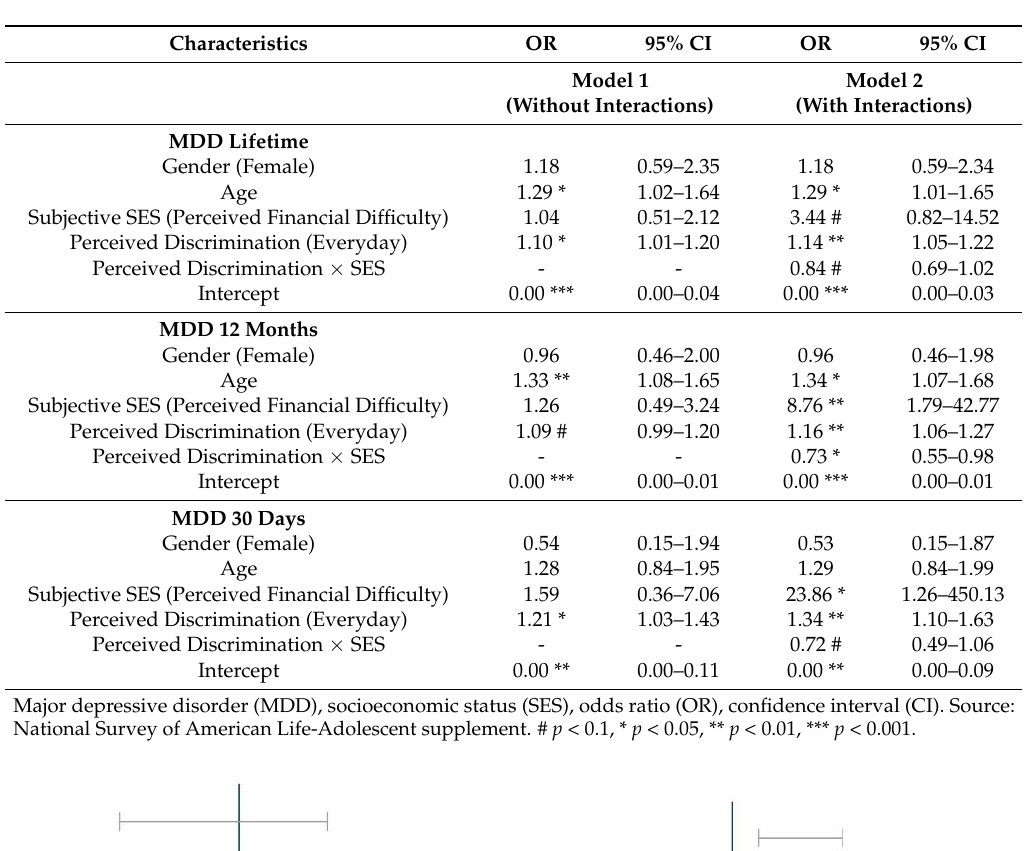
Table 3. Summary of logistic regression on the multiplicative effects of perceived discrimination and subjective SES on MDD ( n = 810).